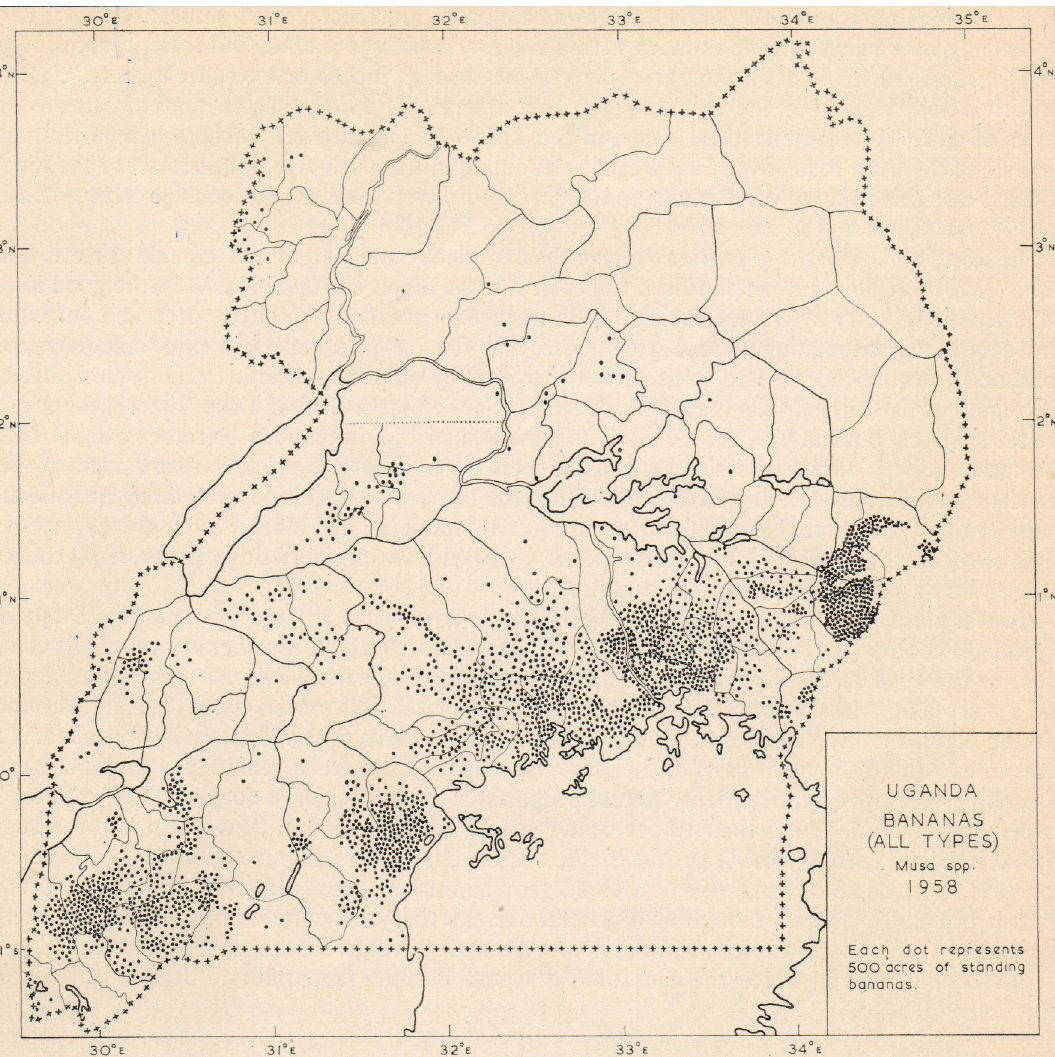
Fig 1. Scanned map of historical locations with banana in 1958. Each dot represents 2.02 km 2 of standing banana. A total of 2400 dots are spread across Uganda equivalent to 4,856 km 2 of banana. Image reproduced with permission of Giles Clark, the copyright